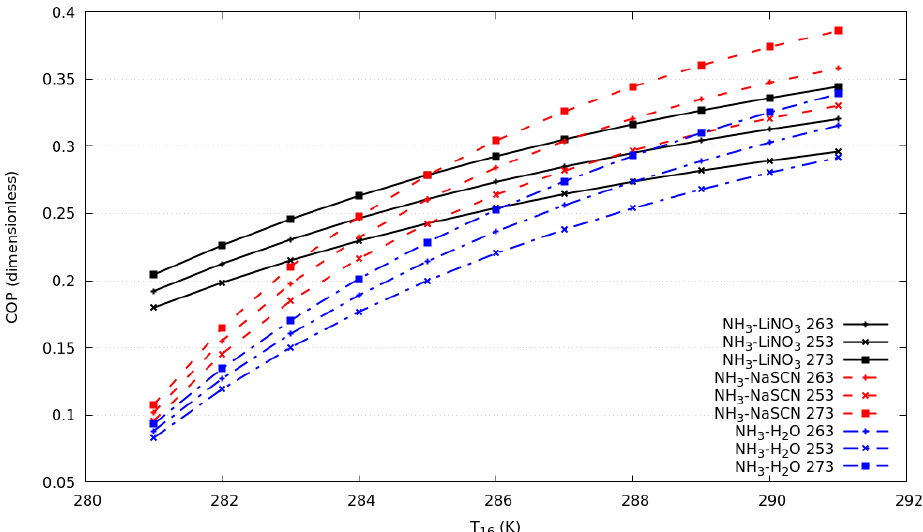
Figure 3. Coefficient of performance against T 16 in compression cycle for evaporation temperature in the absorption cycle of 253 K, 263 K and 273 K.